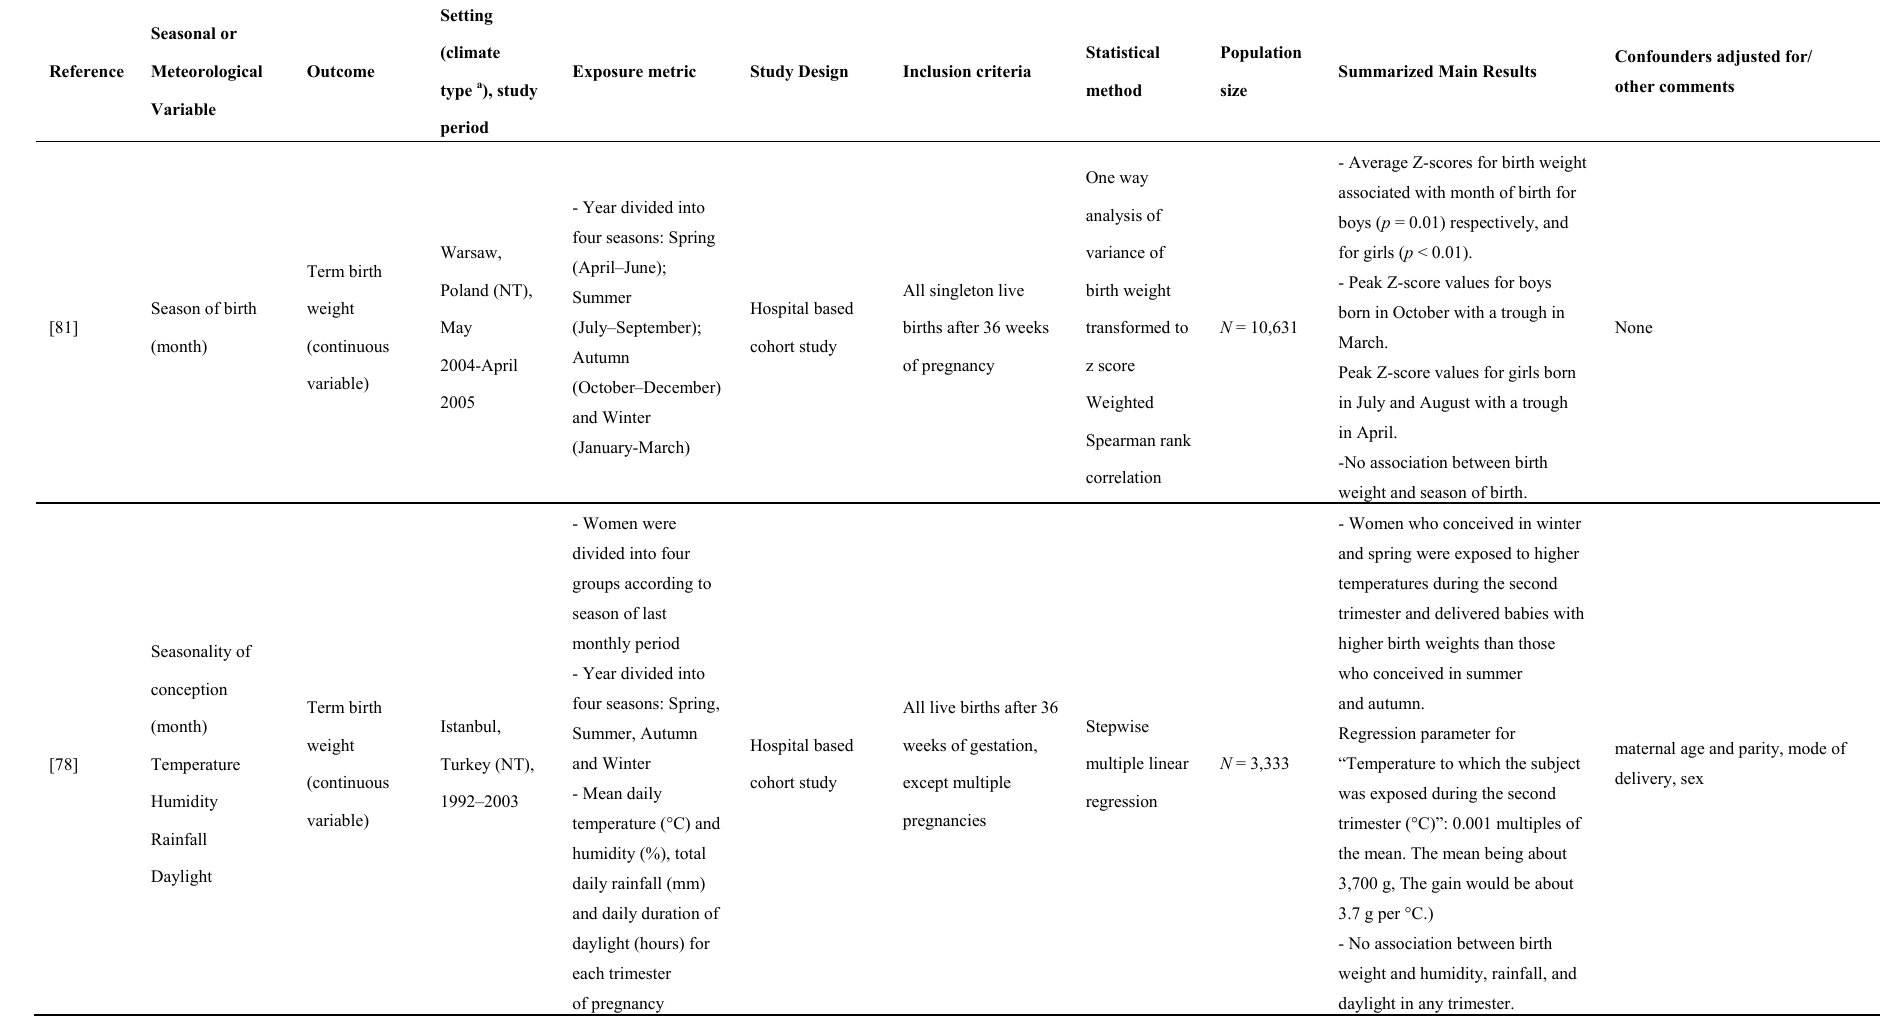
Table 3. Associations between meteorology and birth